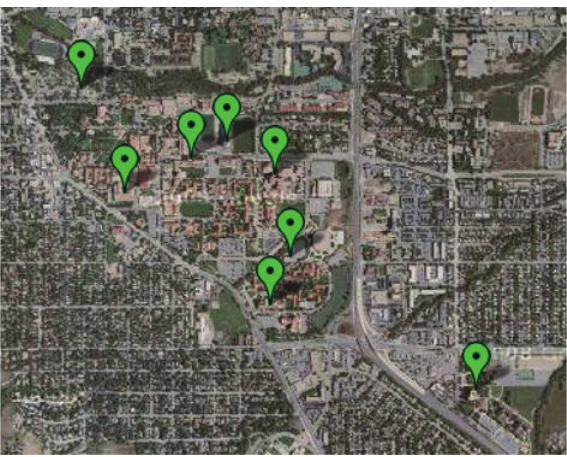
Figure 3: University of Colorado Wide Area Radio Testbed (CU-